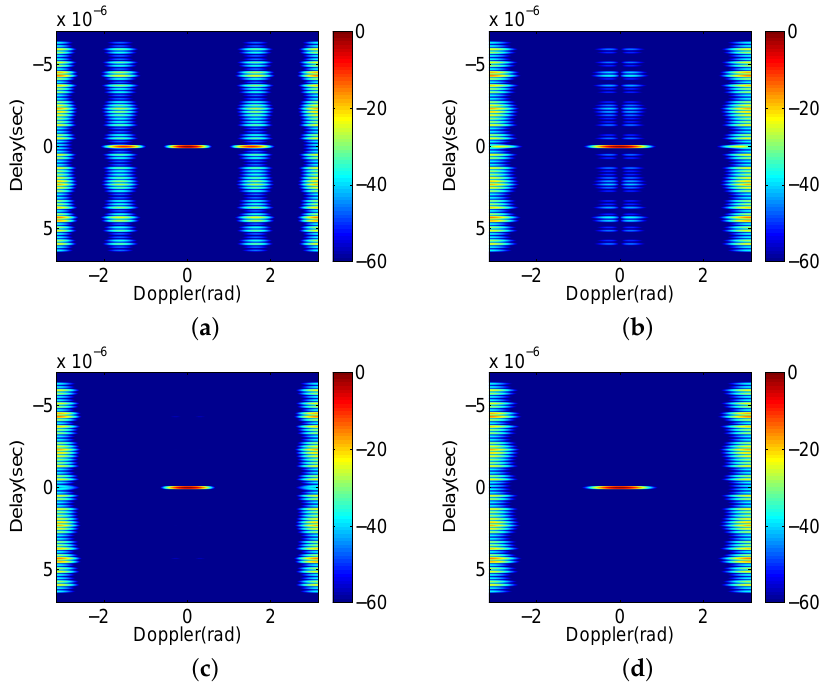
Figure 6. The ambiguity functions of ( a ) MBD algorithm; ( b ) SBD algorithm; ( c ) GBD procedure; ( d ) BD algorithm. (the unit of colorbar is